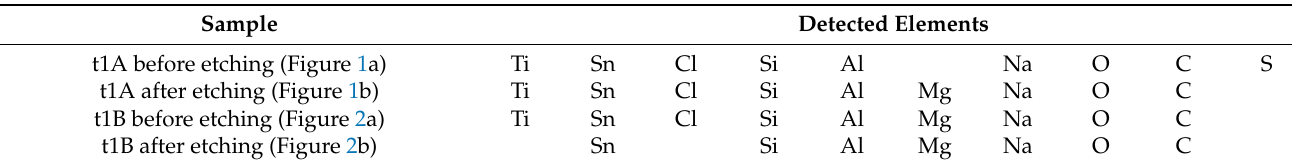
Table 5. Overview of the elements detected with SEM-EDX.